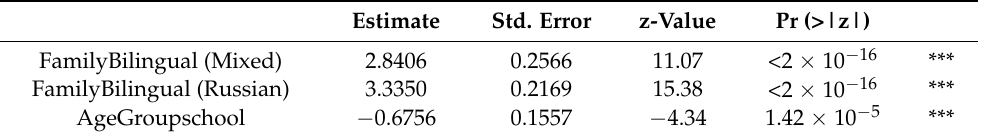
Table 5. Mixed-effects model for perceived accentedness in German: fixed-effects factors. (*** highly